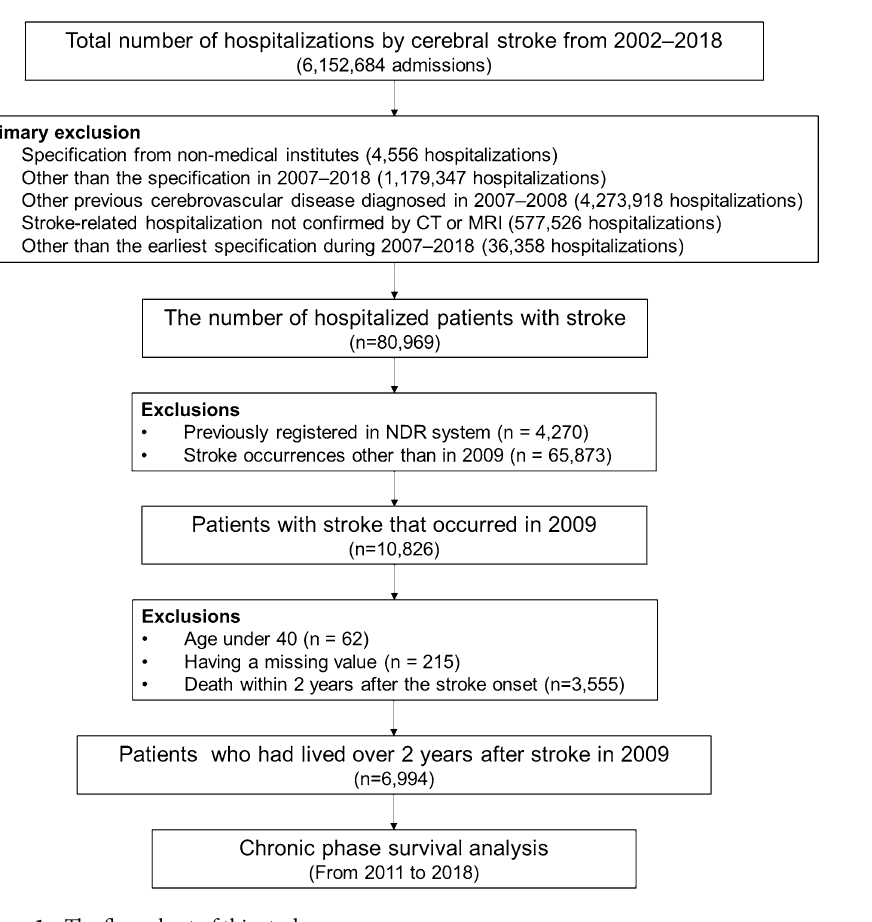
Figure 1. The flow-chart of this